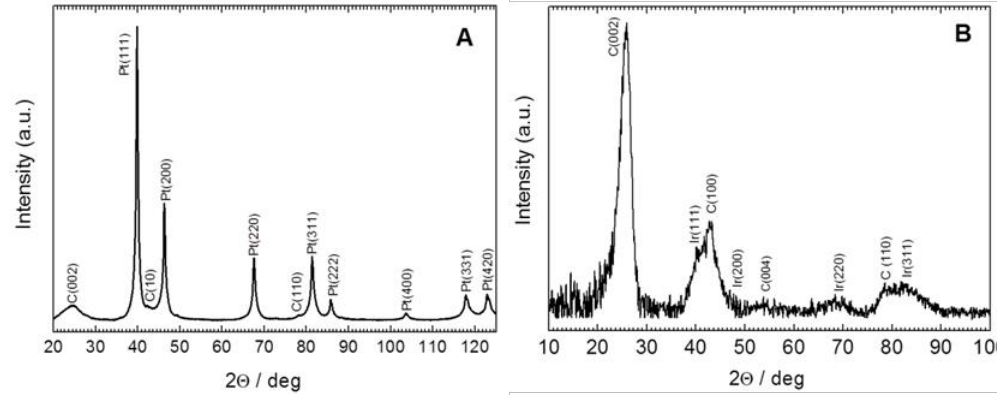
Figure 2 . X-ray powder diffraction (XRD) patterns of Pt/rGO ( A ) and Ir/CNT ( B ) materials. Figure 2. X-ray powder di ff raction (XRD) patterns of Pt / rGO ( A ) and Ir / CNT ( B )